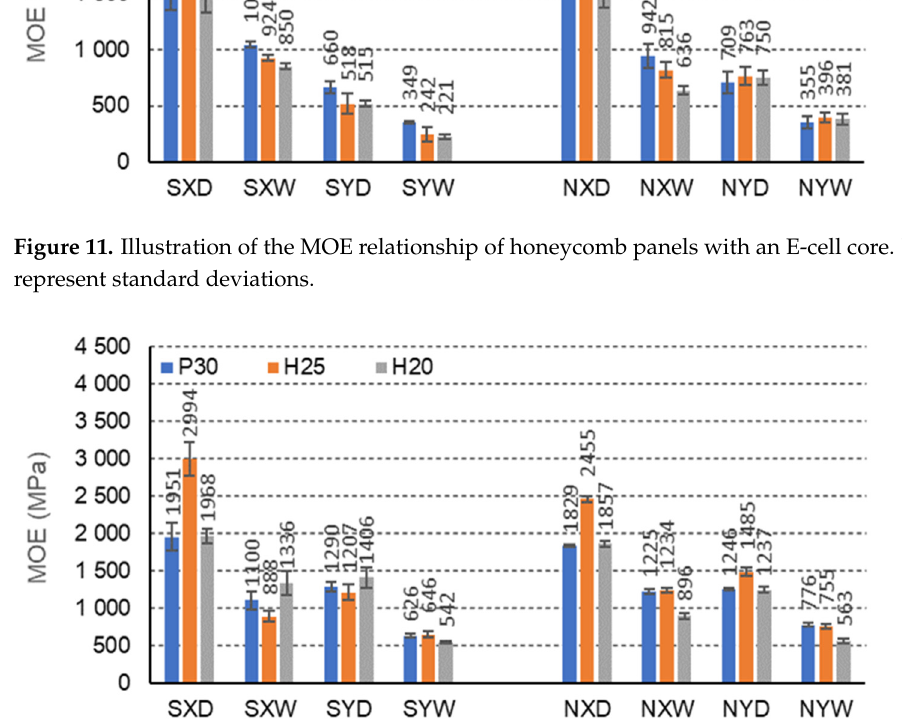
Figure 12. Illustration of the MOE relationship of honeycomb panels with F-type core. Whiskers represent standard deviations.